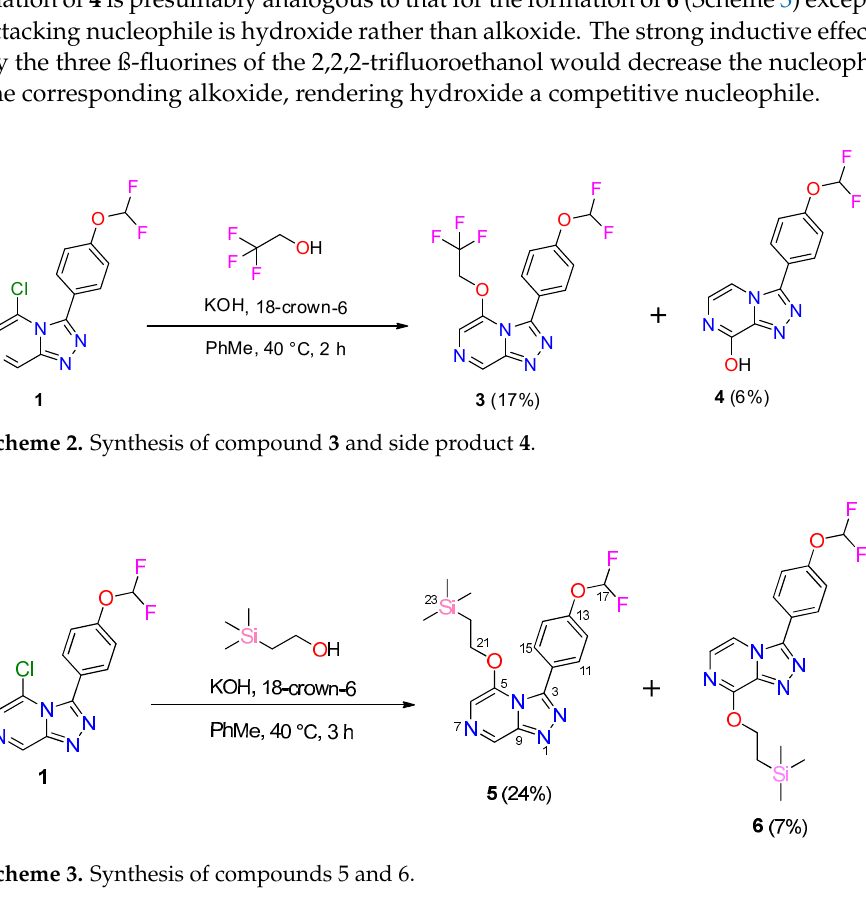
Table 1. NMR data for compound 5 in DMSO- d 6 a